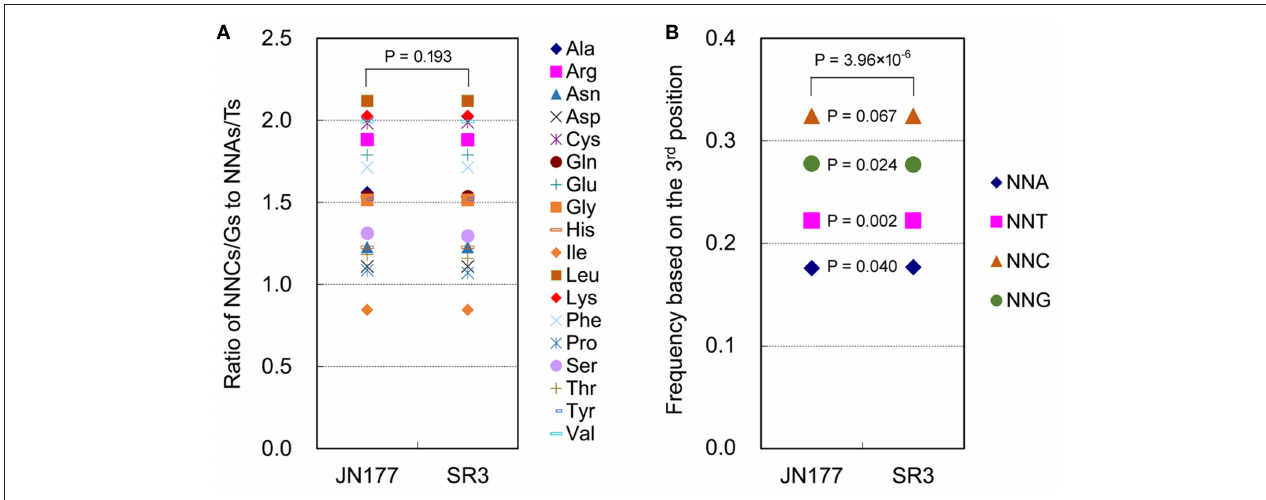
FIGURE 1 | SCUB was shifted in the genome of SR3. (A) The ratios of the frequencies of NNC/NNG SCs to NNA/NNT SCs. NNCs/Gs: SCs with C or G as their final bases; NNAs/Ts: SCs with A or T as their final base. (B) The total frequency of NNA, NNT, NNC, and NNG codons. The total frequency was calculated as the ratio between the number of all SCs ending with A, T, C, or G and the amount of all SCs. The statistical comparison was conducted with chi square ( χ 2 ) test of cross-table